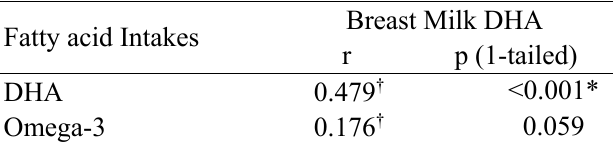
Table 4. Correlation between fatty acid intakes and breast milk DHA Fatty acid Intakes